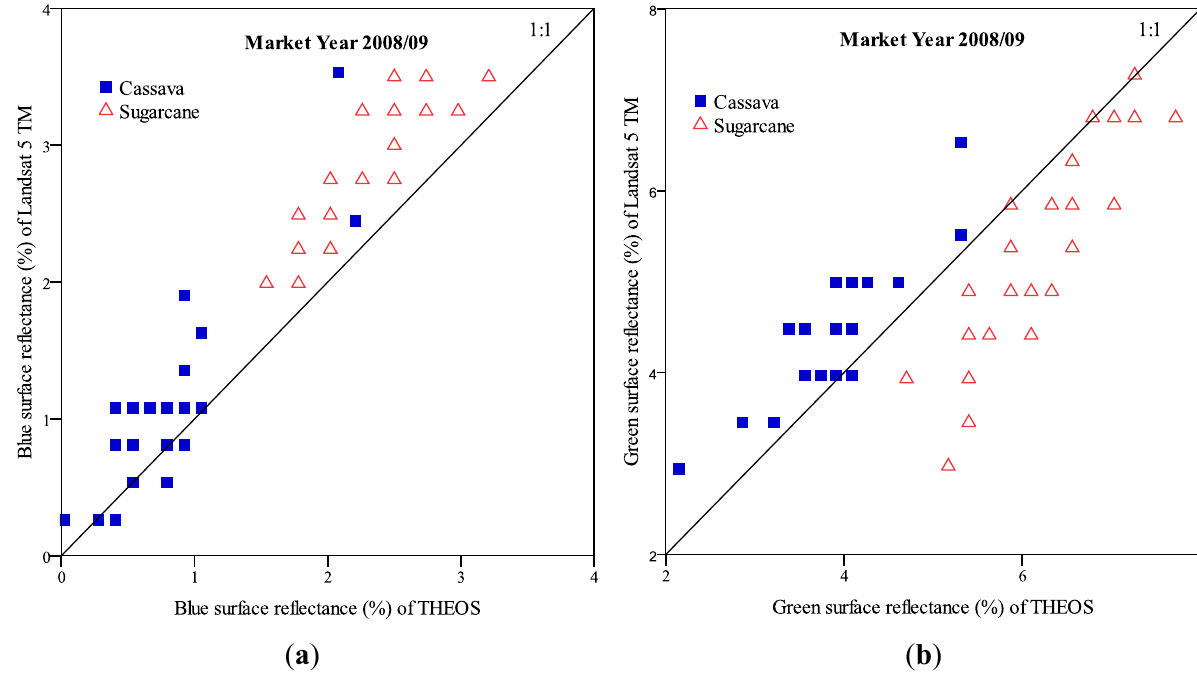
Figure 5. Relationships between THEOS and Landsat 5 TM surface reflectances for